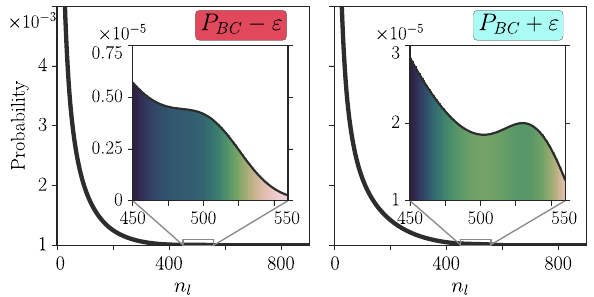
− ε , left panel) and above ( P ( P BC ε ¼ 0 . 016 μ A. Only in the right panel the photon statistics exhibits a second local maximum. The system parameters are the same as in Fig.